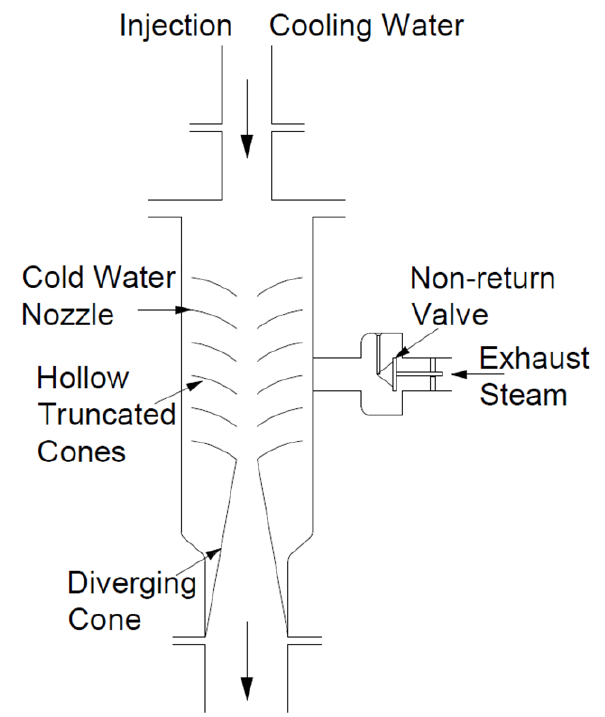
Figure 5. Ejector-flow jet type condenser.